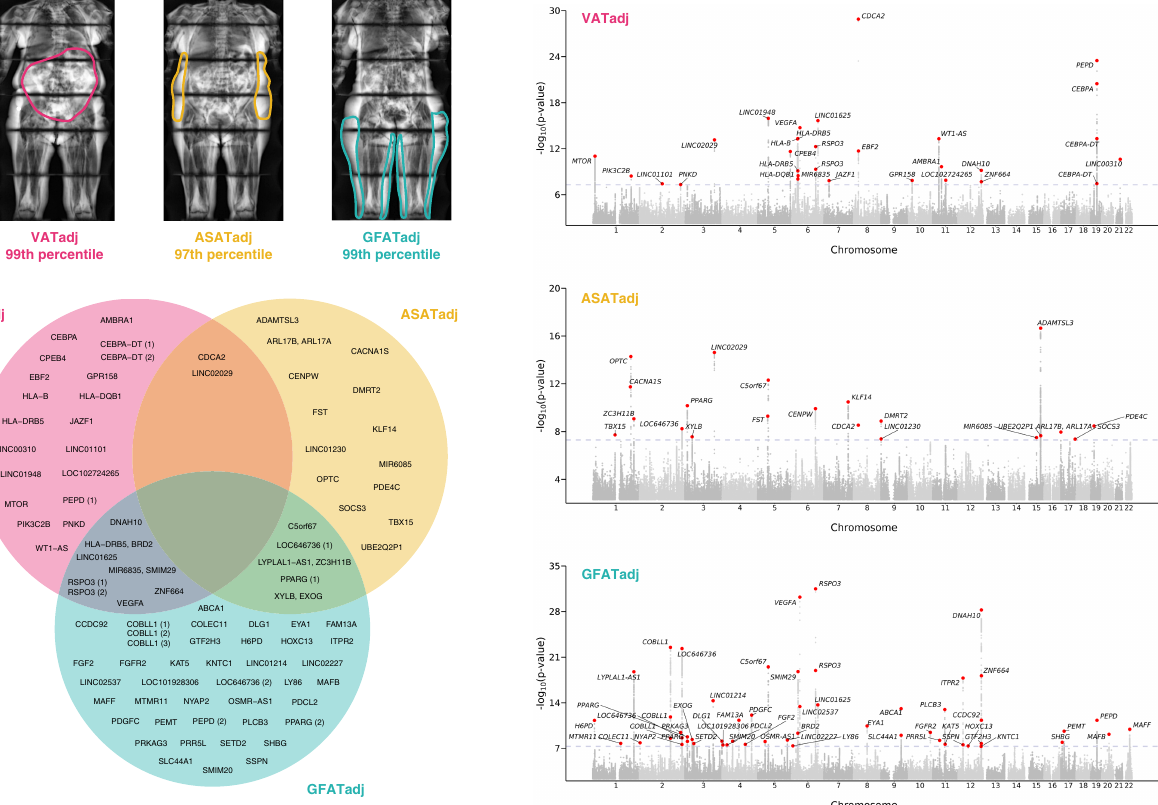
Fig. 1 Genome-wide association studies of VATadj, ASATadj, and GFATadj. (Top left) Three female participants from the UK Biobank with similar age (67 – 70 years) and similar overweight BMI (27.6 – 28.6 kg/m 2 ) with highly discordant fat distributions (right) Manhattan plots for sex-combined GWASs with VAT adjusted for BMI and height (VATadj), ASATadj, and GFATadj. Lead SNPs are described in Supplementary Data 3. (Bottom left) Overlap between VATadj, ASATadj, and GFATadj loci denoted by the nearest gene; lead SNPs of two traits in high LD ( R 2 ≥ 0.1) were plotted in the intersection. GWAS signi fi cance at a commonly used threshold of p < 5 × 10 − 8 was required for inclusion in the Venn